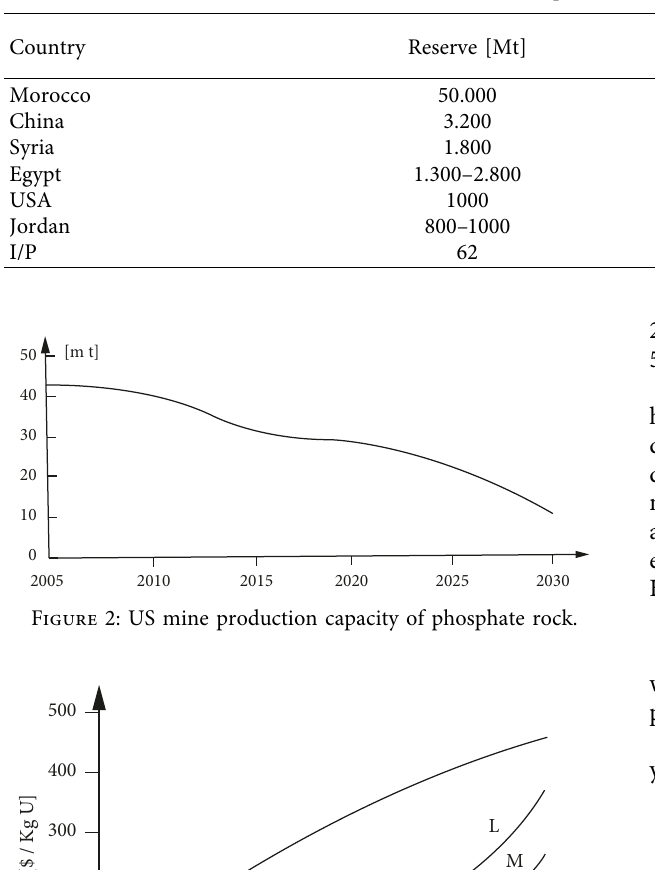
Table 3: Annual mine production, [20, 21] of phosphate rock.